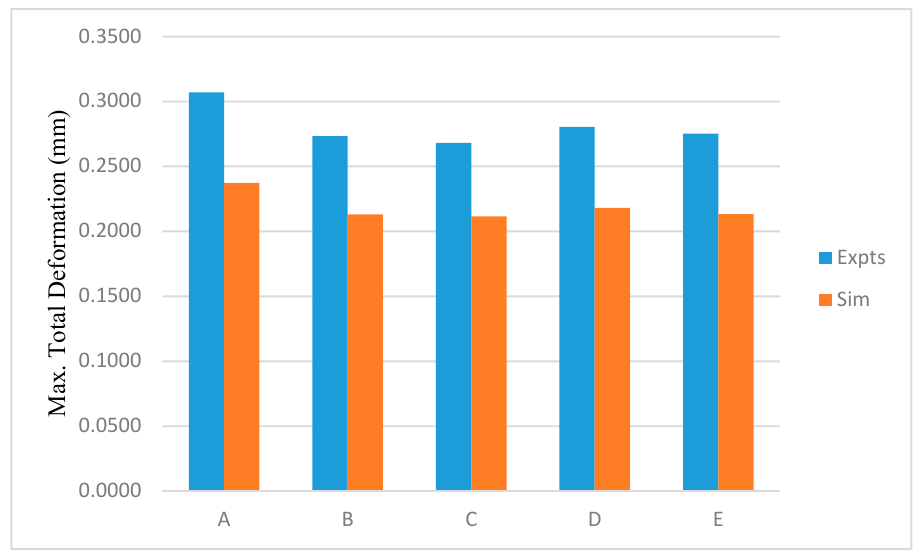
Figure 9. Maximum total deformations (mm) obtained using experiments and simulations.